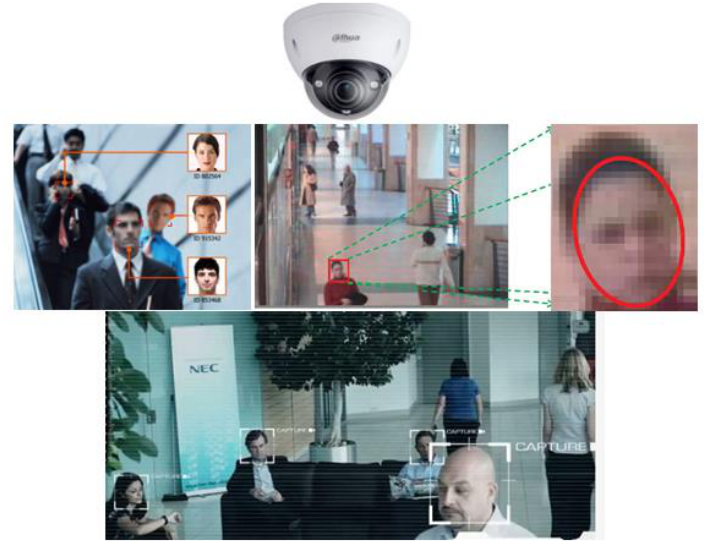
Figure 44. Examples of face recognition in video surveillance.